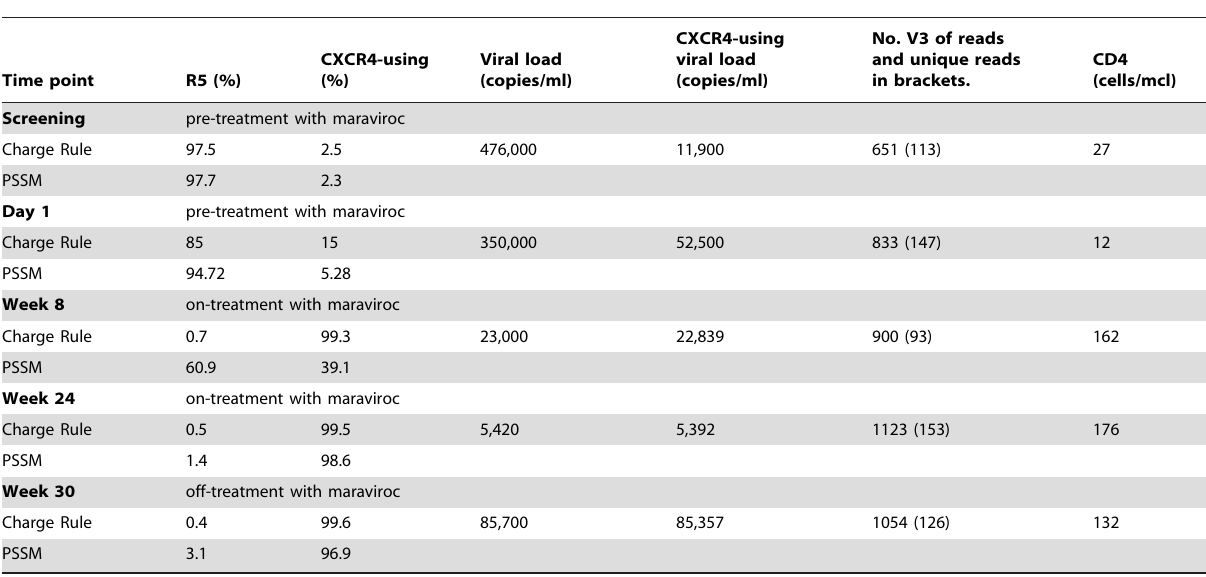
Table 4. Patient E tropism predictions.